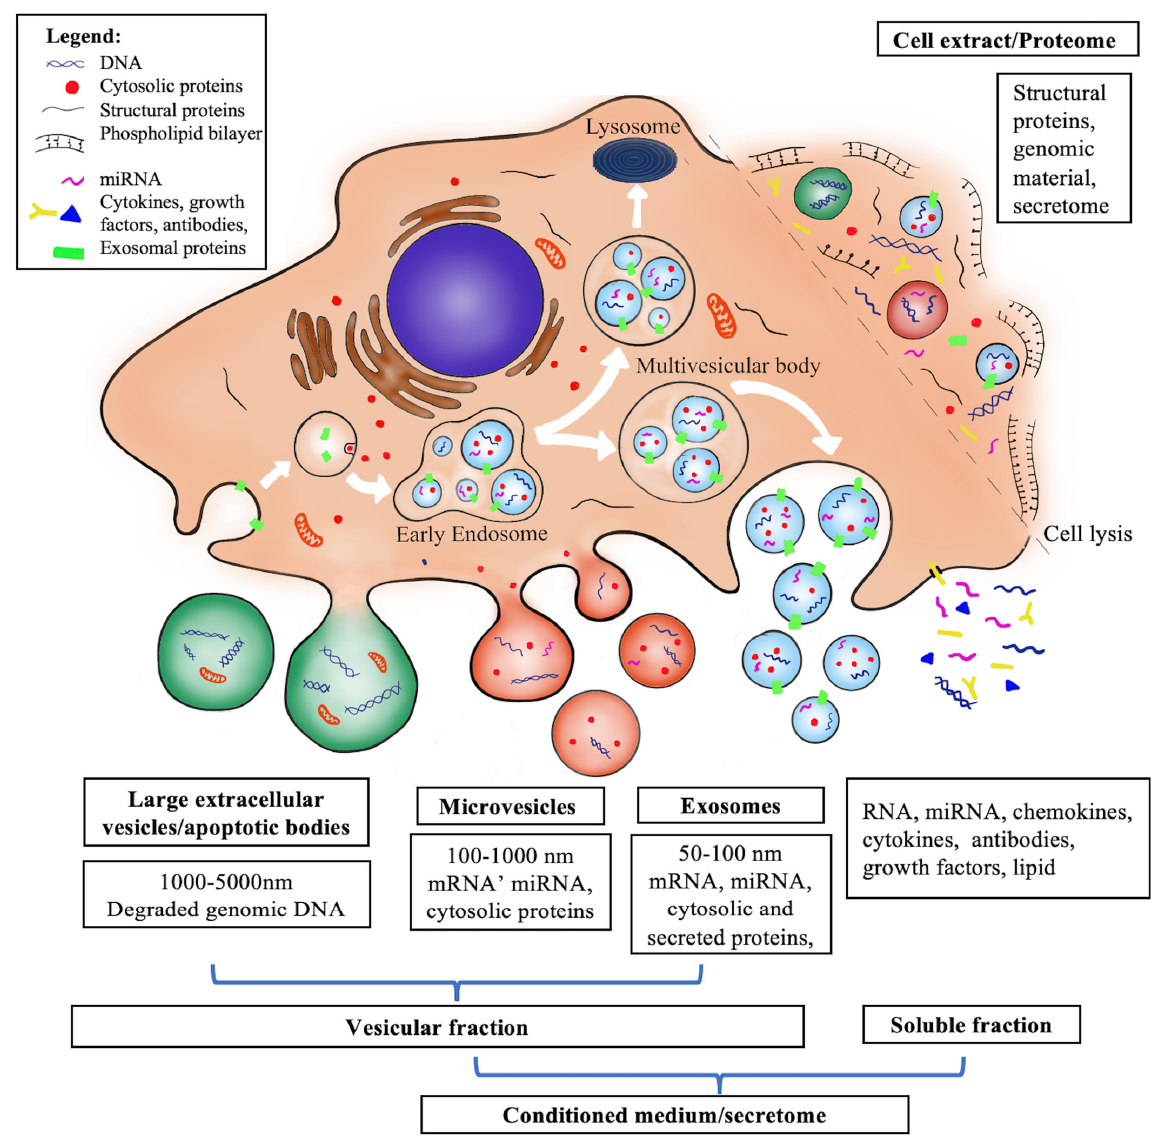
Figure 2. Mesenchymal stem cell-derived cell-free therapies and their components. Various particles are secreted from cells during function, bundled as vesicles or as soluble factors directly in the extracellular space. Vesicular fraction contains apoptotic bodies (1000–500 nm), microvesicles (100–1000 nm), and exosomes (50–100 nm). Apoptotic bodies are formed in response to apoptotic signals through the budding of the cell membrane and contain genomic material and mitochondria. Microvesicles are also created by the outward budding of the cell surface, while exosomes are secreted by the inward blebbing of the endosomal membrane (White arrows). Microvesicles and exosomes can contain receptors, transcription and transduction factors, enzymes, growth factors, lipids, and nucleic acids (DNA, mRNA, miRNA). The soluble fraction contains proteins, growth factors, and chemokines. Cell secretome or conditioned medium comprise of all the above. On the other hand, cell extract contains the cell secretome and the proteome (structural and cytoplasmic proteins, genomic material, and organelles) as it is obtained by whole cell lysis.